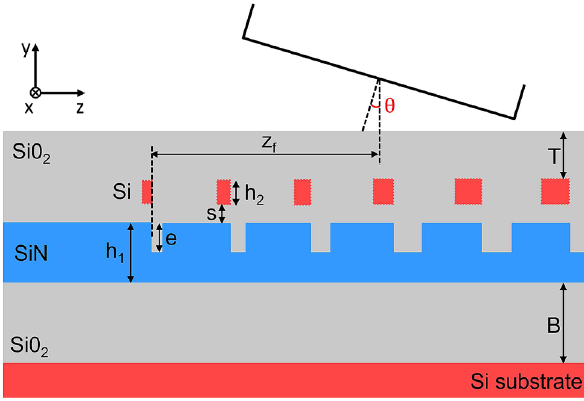
Figure 1. 2D schematic view of the proposed dual-level Si–Si 3 N 4